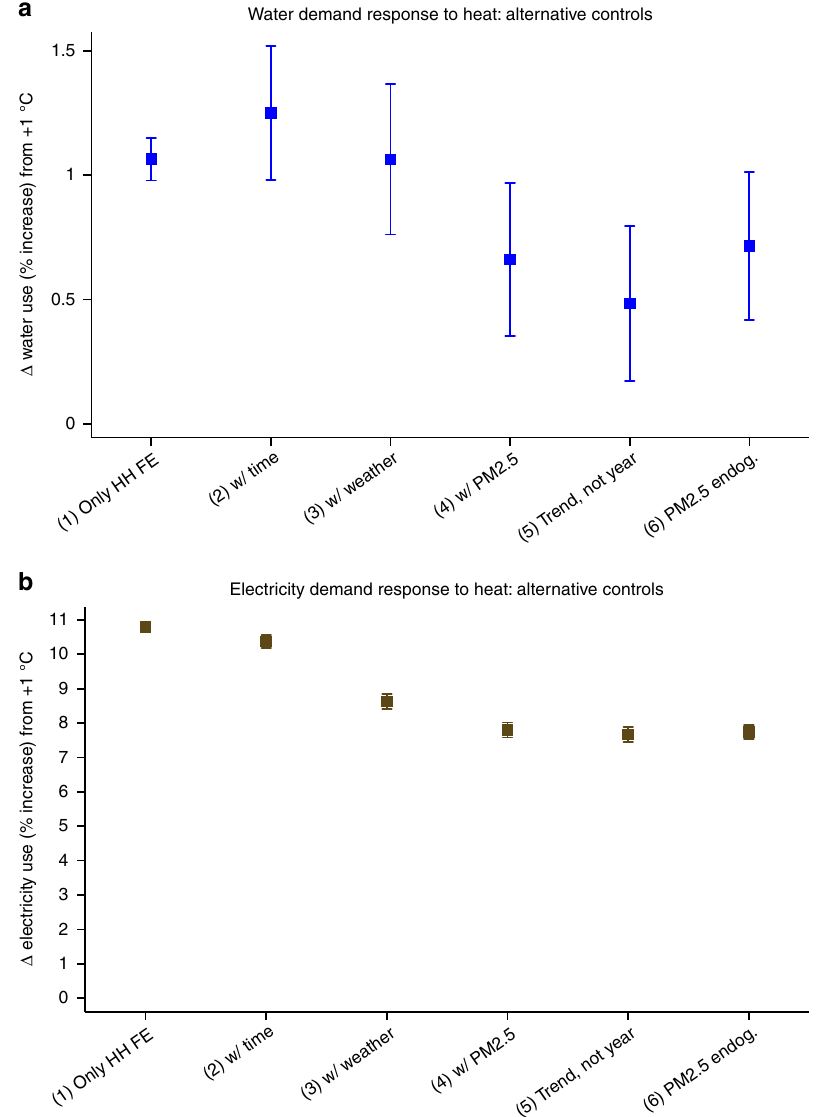
Fig. 3 Household demands for water and electricity respond to heat. 95% Con fi dence intervals for the percent increase in a water use and b electricity use, from a + 1 °C variation in the average daily mean temperature — the key regressor. All speci fi cations include a full set of household fi xed effects. Relative to speci fi cation 1, speci fi cation 2 includes time controls. Relative to 2, speci fi cation 3 includes weather controls. Relative to 3, speci fi cation 4 controls for average daily mean PM 2.5 . Relative to 4, speci fi cation 5 replaces year fi xed effects with a linear time trend. Relative to 4, speci fi cation 6 instruments